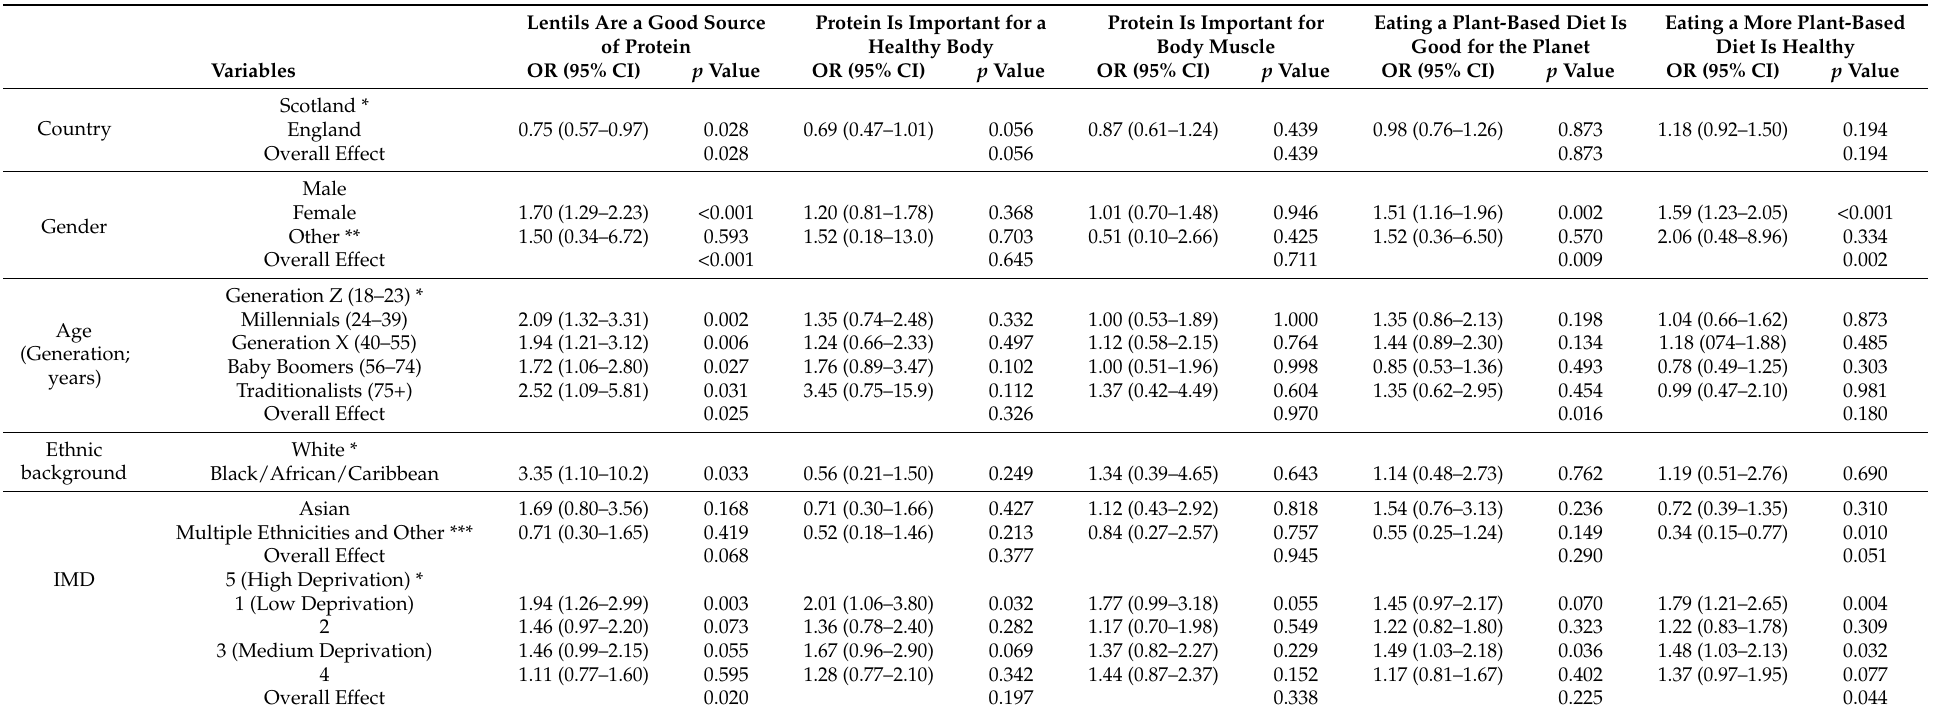
Table 5. Sociodemographic groupings showing agreement with statements about protein-multivariate model analysis. Lentils Are a Good Source Protein Is Important for a Protein Is Important for Eating a Plant-Based Diet Is Eating a More Plant-Based of Protein Healthy Body Body Muscle Good for the Planet Diet Is